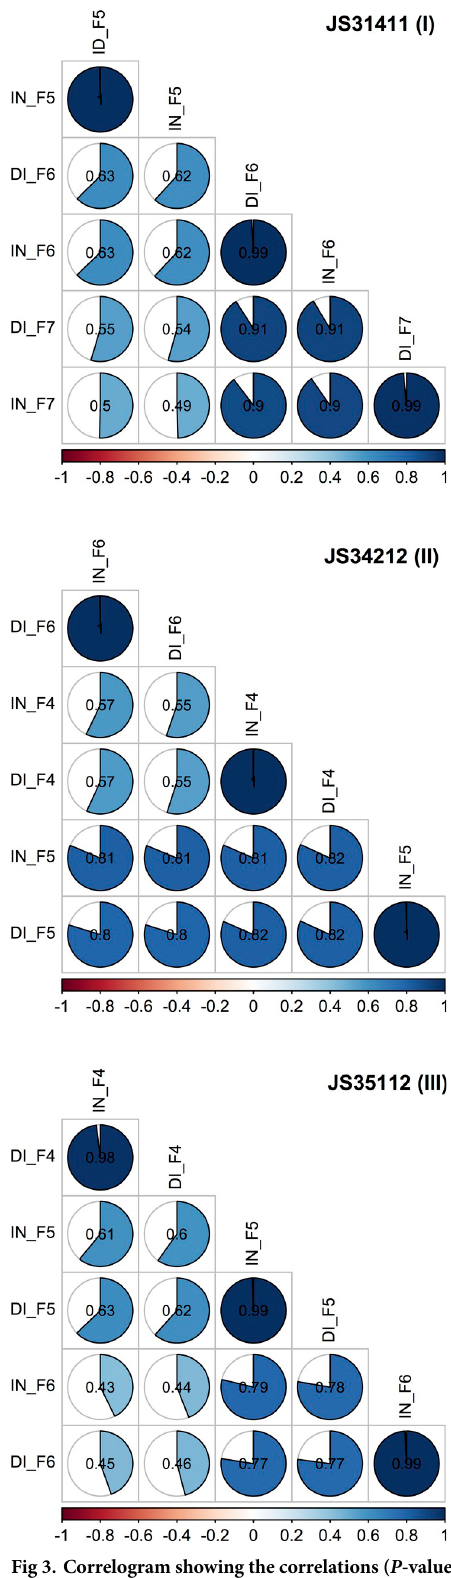
Fig 3. Correlogram showing the correlations ( P -value � 0.01) between traits and generation of RILs. Pearson’s correlation coefficients are indicated in the cells. https://doi.org/10.1371/journal.pone.0211920.g003 PLOS ONE | https://doi.org/10.1371/journal.pone.0211920 February 8,